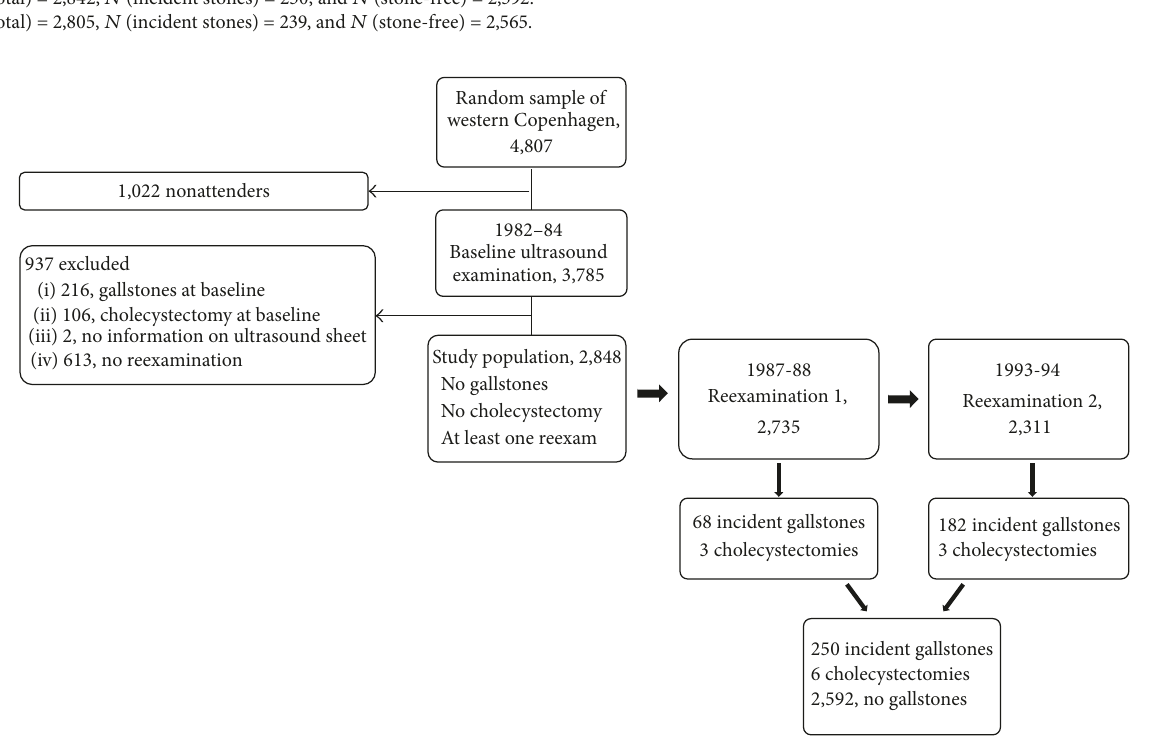
Figure 1: Study design and participant